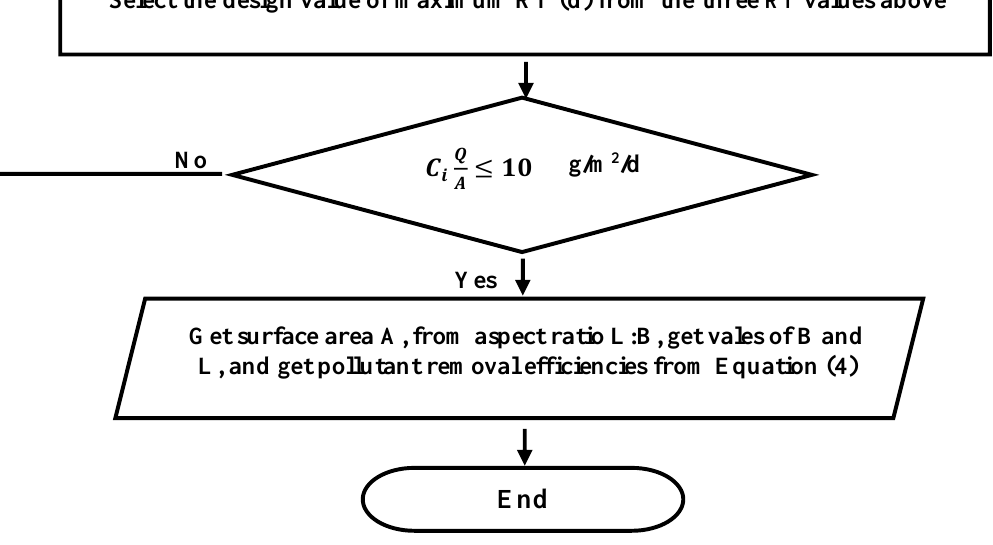
Figure 3. Model flowchart to size the HSSF and VF-CWs and obtain the pollutants removal effica- cies. Table 2. Model input data for the proposed wastewater treatment system as VF-CW after the HSSF- CW.